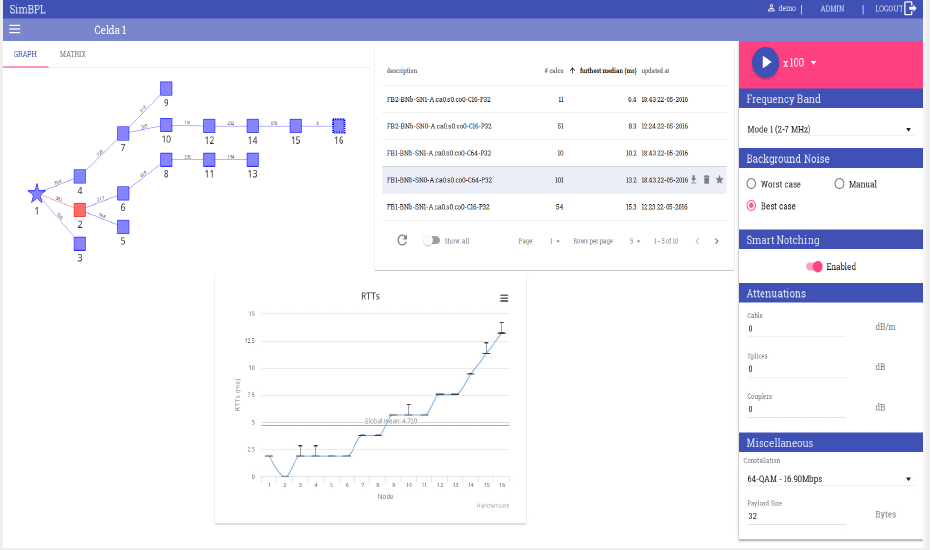
Figure 6. Dashboard of the web application developed for SimBPL.